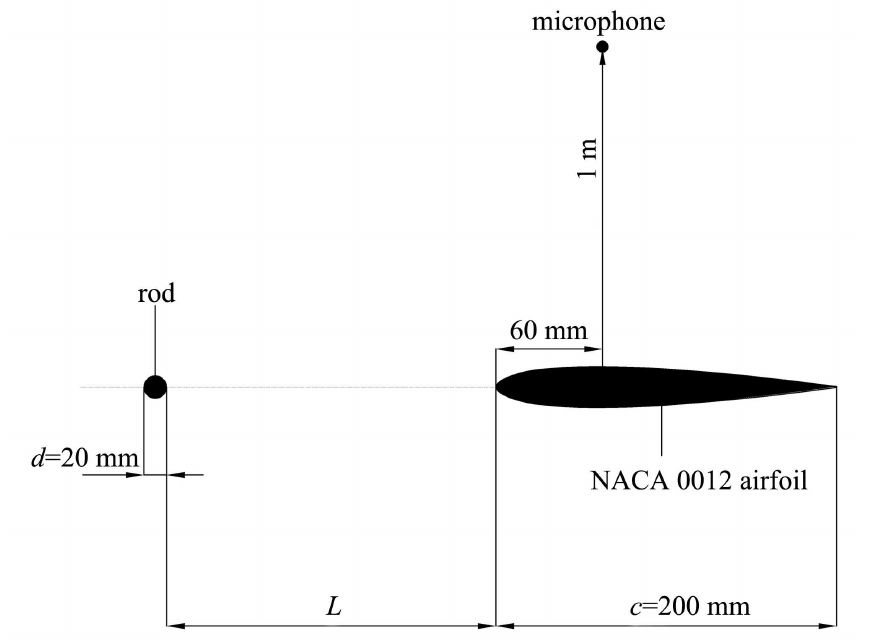
Figure 1. Sketch of the experimental set-up (not to